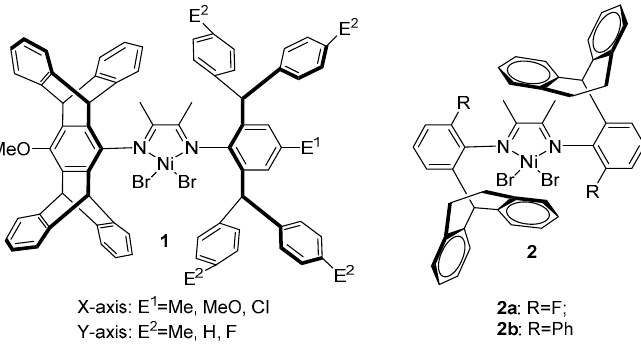
Figure 1. α -Diimine Ni(II) catalysts 1 and 2a , b from Jian group.